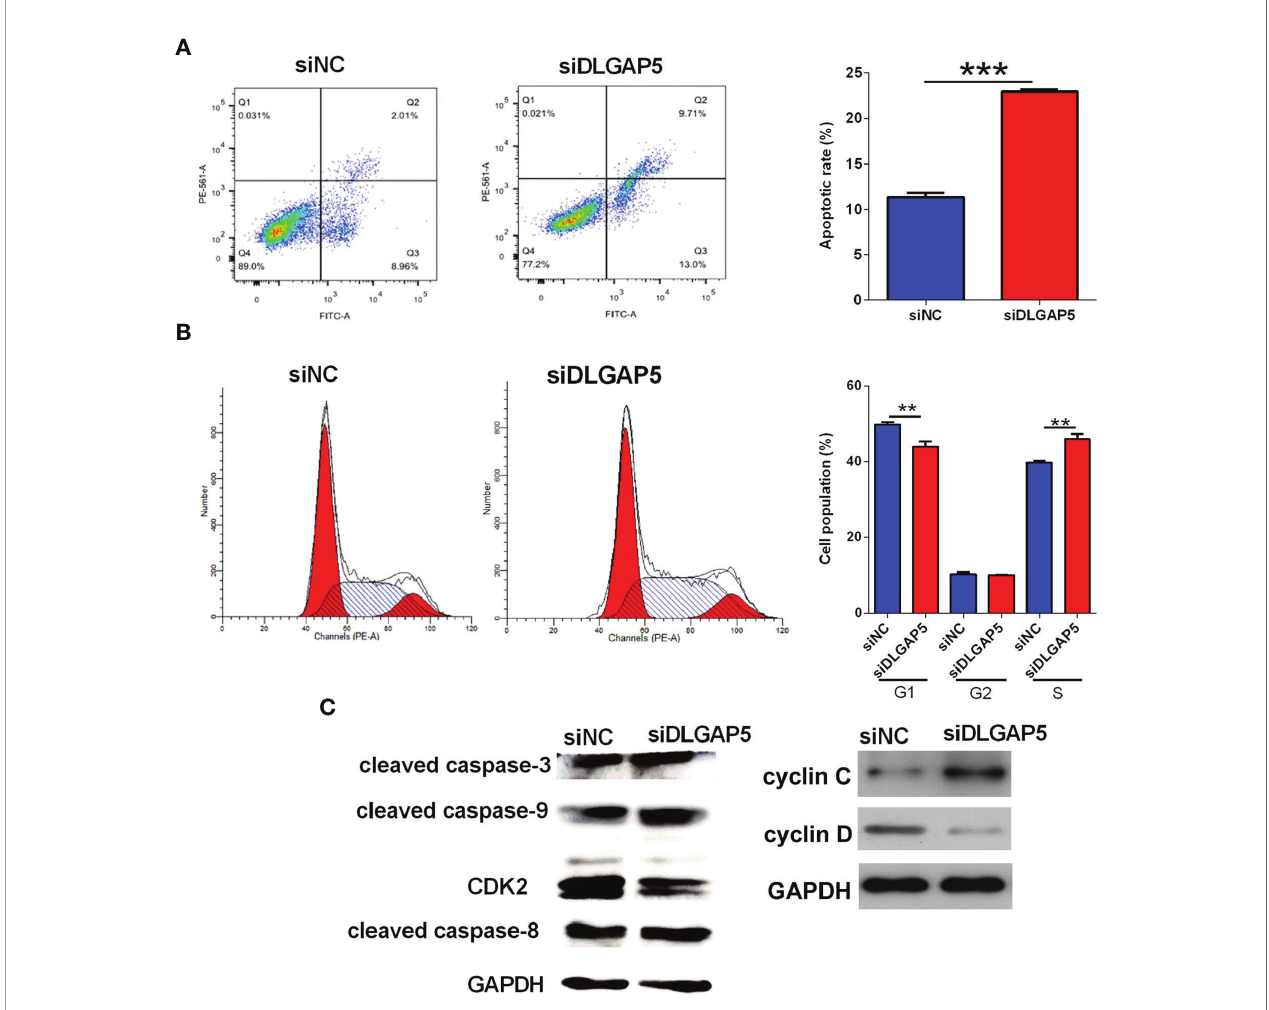
FIGURE 8 | Effects of DLGAP5 knockdown on the granulosa cell apoptosis and cell cycle. Granulosa cells were transfected with si-NC or si-DLGAP5, and after siRNA transfection, (A) the cell apoptotic rates and (B) cell cycle of granulosa cells were determined by fl ow cytometry; (C) the protein levels of cleaved caspase-3, cleaved caspase-9, CDK2, cleaved caspase-8, cyclin C and cyclin D in granulosa cells were determined by Western blot assay. N = 3. **P < 0.01 and ***P <